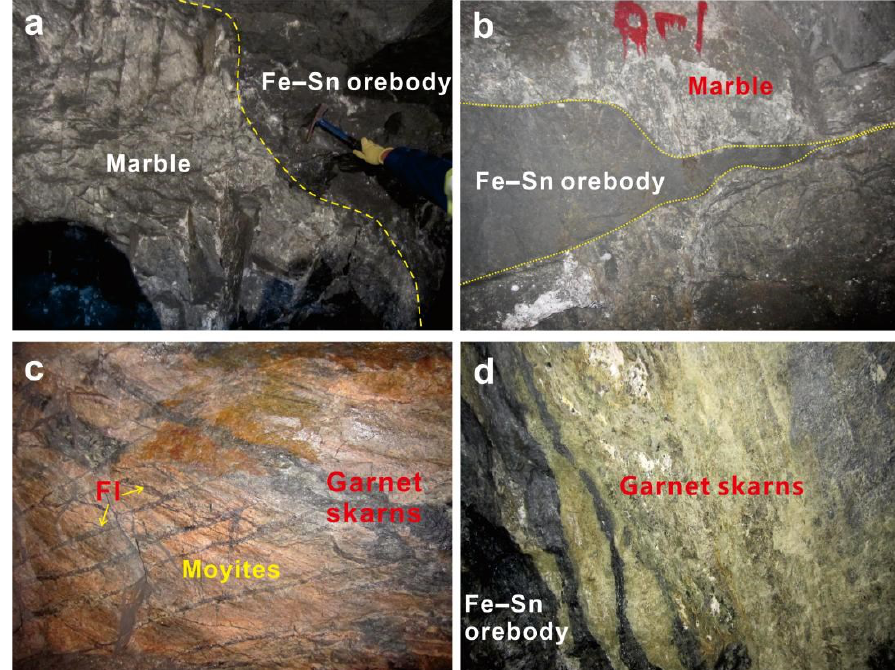
Figure 3. Relations between ore body, alteration, and host rocks. ( a ) Most of the Fe–Sn ore bodies are irregularly lamellar or lenticular and located within the contact zone between marble and moyites; ( b ) Some of the Fe–Sn ore bodies are veined interspersed marble; ( c ) Fluorite mainly replaced the garnet skarns and moyites as a banding distribution; ( d ) Garnet skarns occur either surrounding them or scattered within them as lenses.